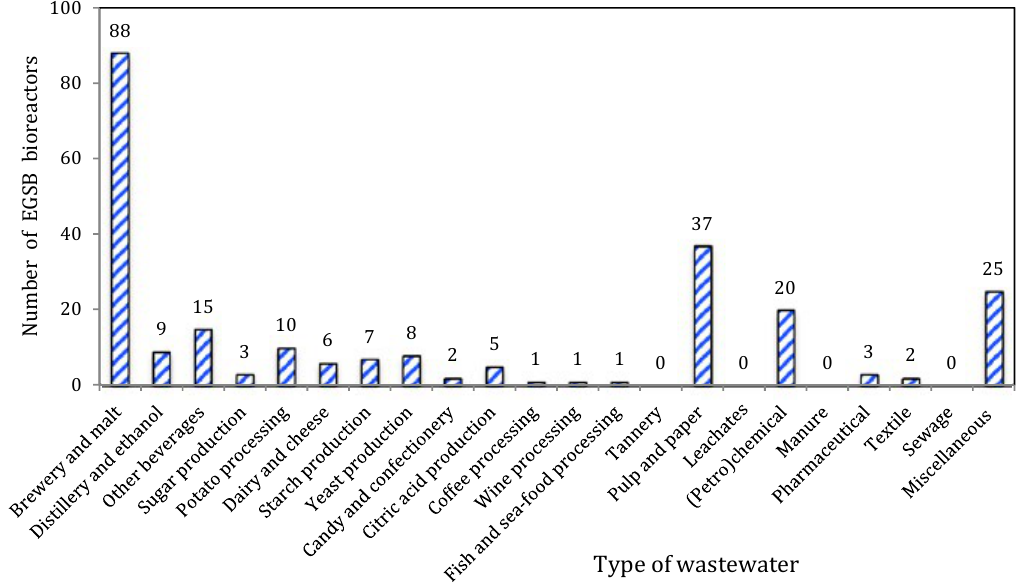
Fig. 6: Number of the commercial scale EGSB bioreactors built in the world for treating wastewaters